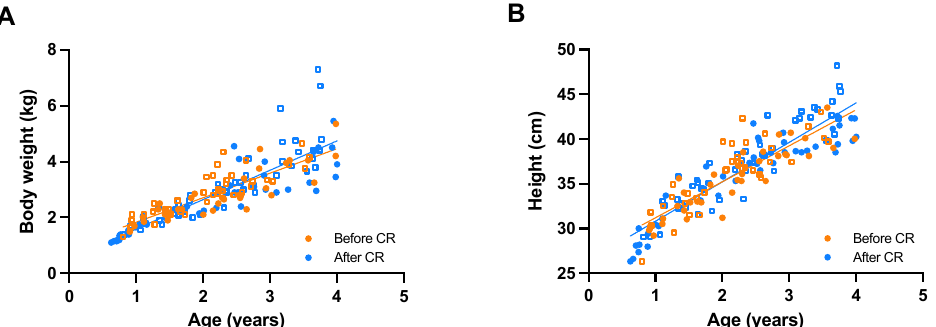
Figure 3. Growth patterns of immature male and female long-tailed macaques based on body weight ( A ) and height ( B ) before and after caloric restriction (CR). Circles represent females; squares represent males.